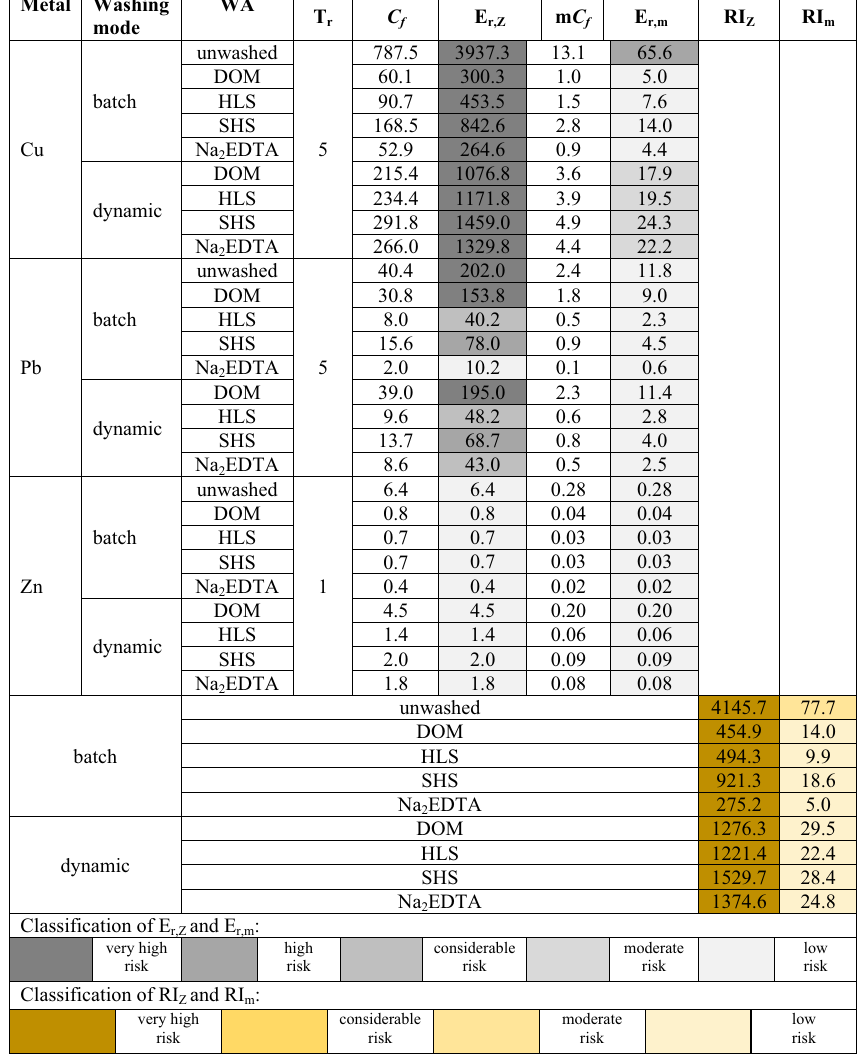
Table 3. Comparison of potential ecological risk factors ( E r ,Z , E r ,m ) and potential ecological risk indices ( RI Z , RI m ) in soil before and after